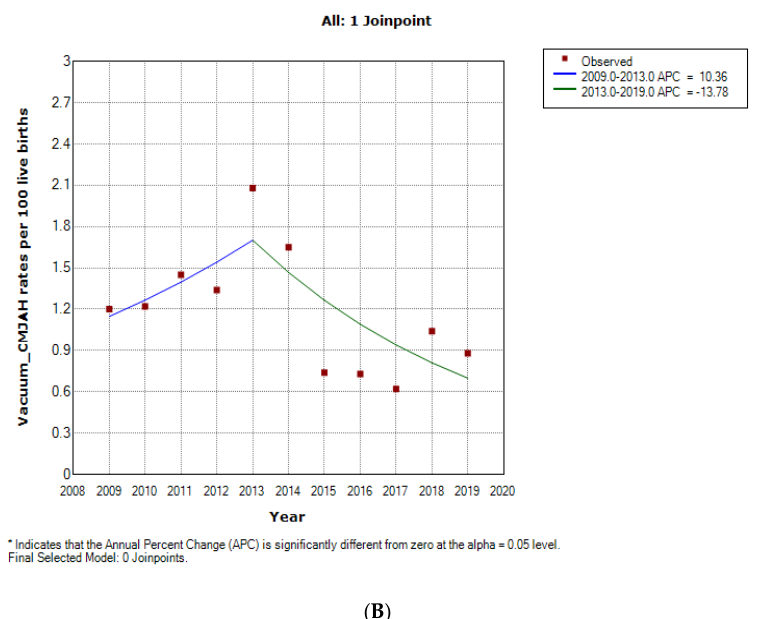
Figure 6. Join point regression analysis of the trends in Forceps deliveries ( A ) and Vacuum ( B ) rates at Charlotte Maxeke Johannesburg Academic Hospital, 2009 – 2019.